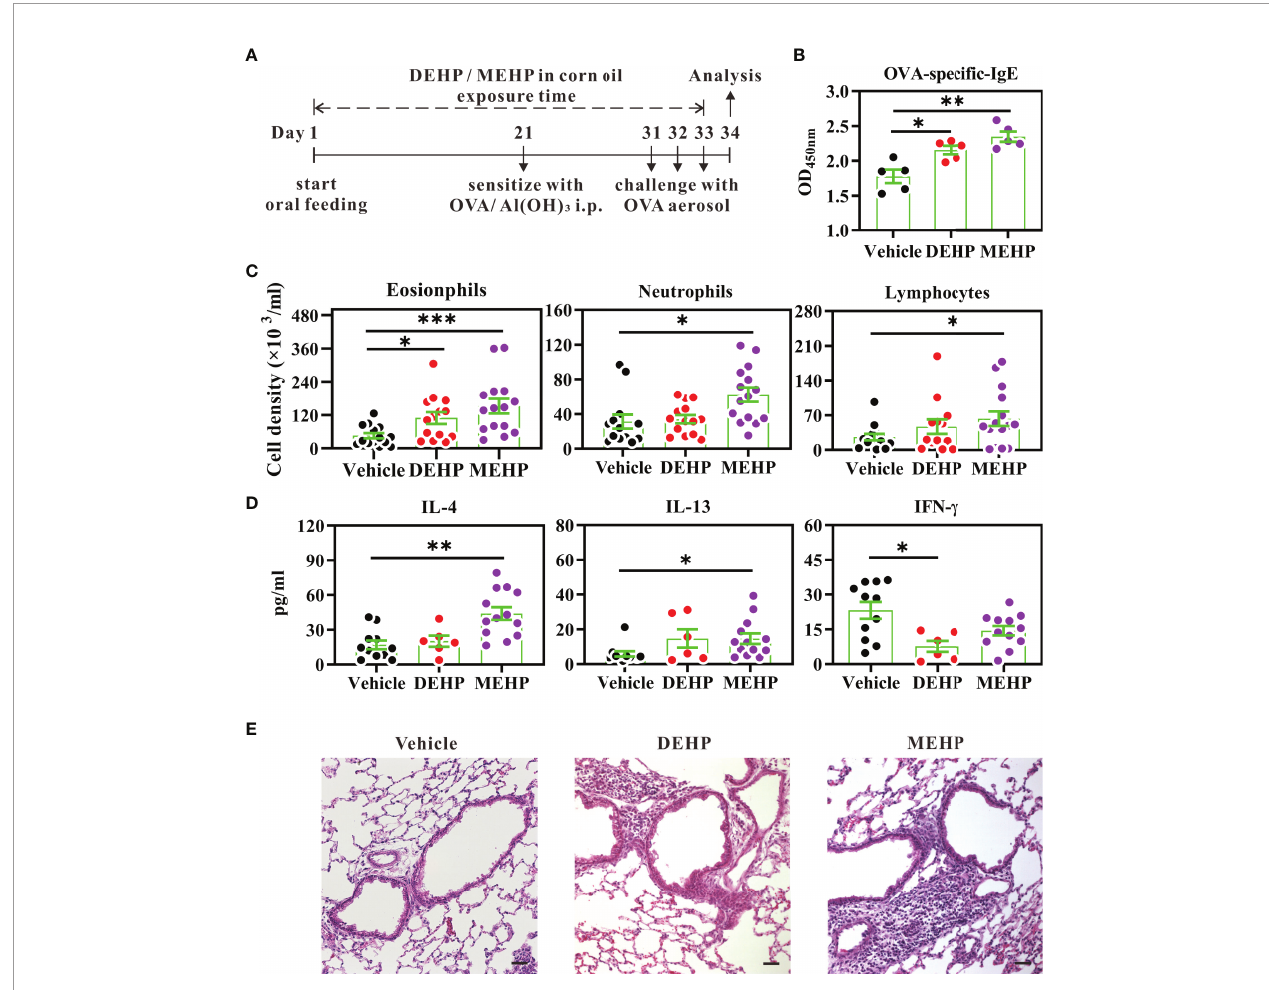
FIGURE 1 | Effect of DEHP exposure on allergic lung in fl ammation in a BALB/c mouse model of mild asthma. (A) Schematic depiction of the model of OVA-induced asthma, upon exposure to DEHP or MEHP. BALB/c mice were given oral DEHP or MEHP daily, at a dosage of 37 m g/kg BW, and all mice were immunized and challenged with OVA. (B) Serum levels of OVA-speci fi c IgE (10-fold dilution) were determined using ELISA. Cell subsets (C) and cytokine levels (D) in BALF were analyzed using fl ow cytometry and ELISA, respectively. (E) Representative lung sections stained with hematoxylin and eosin. Scale bar: 50 m m. Results have been represented as mean ± SEM. *P < 0.05, **P < 0.01, and ***P < 0.001 vs. vehicle (as assessed using Mann – Whitney U test). In (B) n = 5 mice per group; in (C, D) n = 14 or 15 mice per group in four independent experiments; in (E) data are representative of two independent